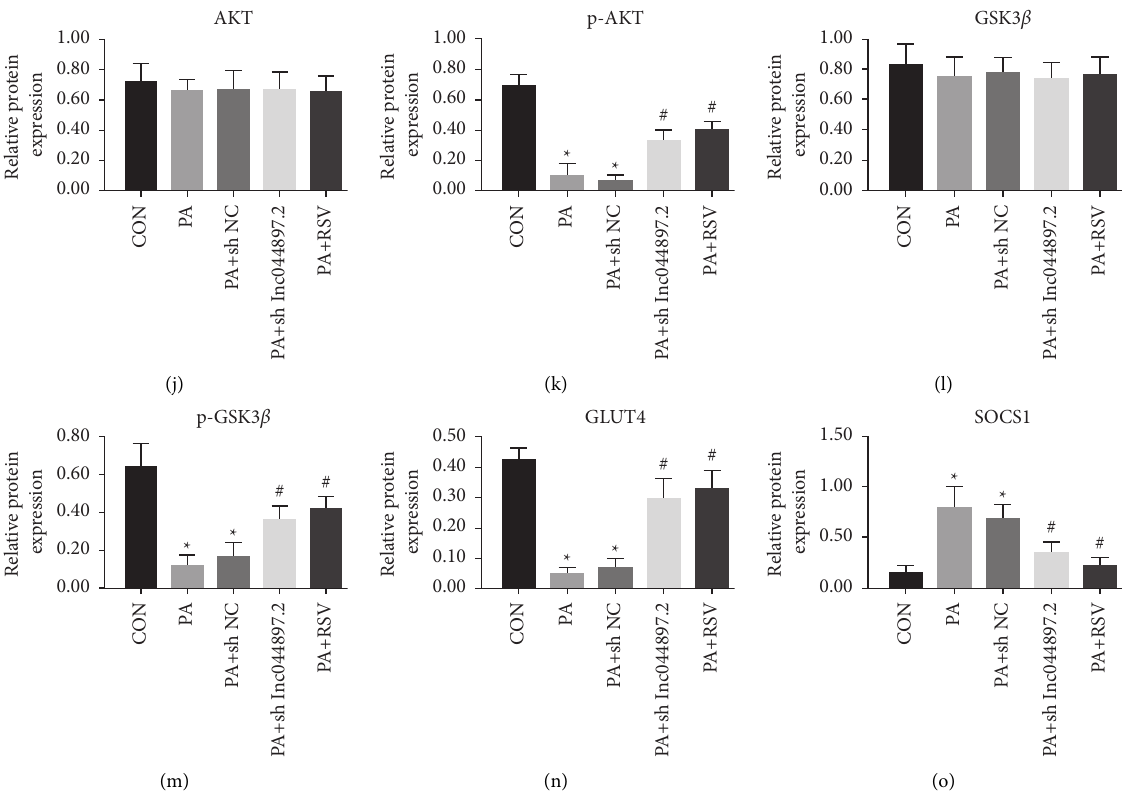
Figure 6: Resveratrol improved skeletal muscle insulin resistance by downregulating the lncRNA NONMUT044897.2 in vitro . Val- idation of lncRNAs NONMMUT044897.2 (a), NONMMUT139818.1 (b), NONMMUT00000181045(c), NONMMUT071570.2 (d), and NONMMUT06516.2 (e) by RT-qPCR. Expression of miR-7051-5p mRNA (f) and NONMMUT044897.2 mRNA (g) after shRNA transfection into C2C12 cells in different groups. (h) Glucose concentrations in the culture medium after shRNA transfection into C2C12 cells in different groups. (i) Protein bands of insulin signaling pathway-related molecules. Densitometric analysis of (j) AKT, (k) p-AKT, (l) GSK3 β , (m) p-GSK3 β , (n) GLUT4, and (o) SOCS1. Data are presented as the mean ± SD ( n � 6). ∗ P < 0 . 05 versus CON, # P < 0 . 05 versus PA, and δ P < 0 . 05 versus PA +